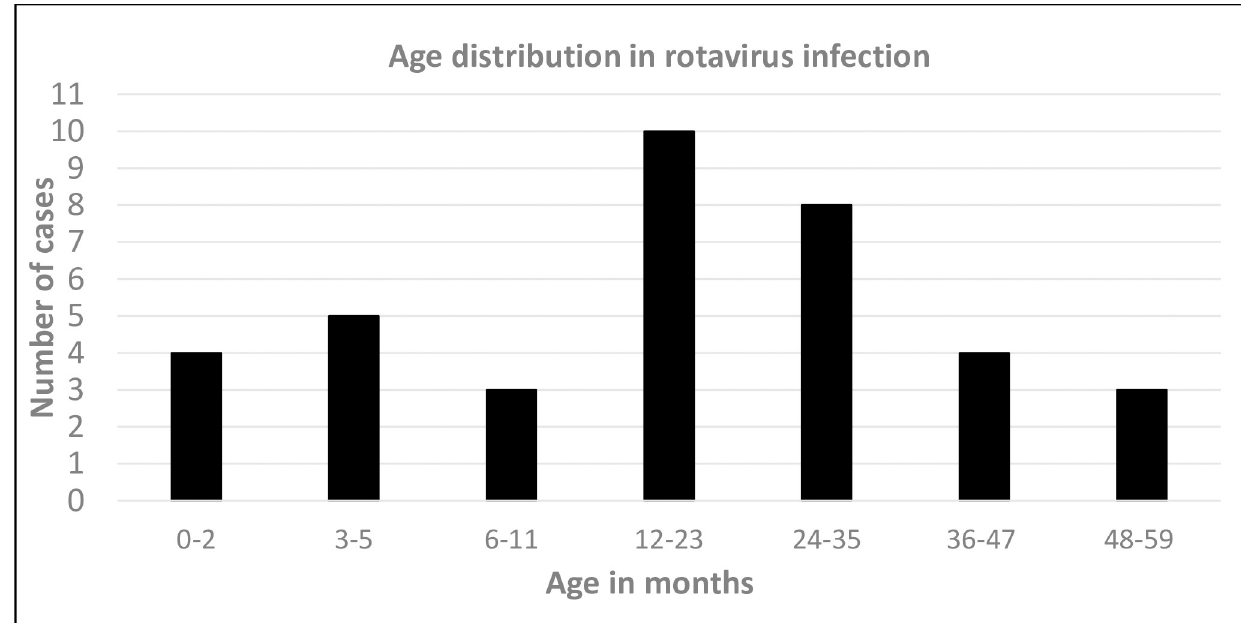
Fig 1. Age distribution. The number of cases with rotavirus diarrhea distributed according to age.